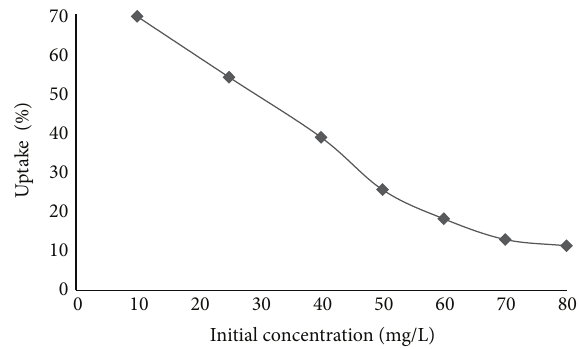
Figure 2: Variation of uptake percentage with initial concentration of cesium for its sorption on kaolin. Operating conditions: 50mL solution, pH = 6, 250 mg kaolin, and shaking time =